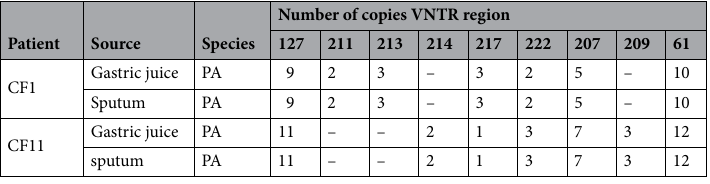
Table 3. VNTR profile for PA isolated form Gastric juice and sputum sample of patient 1 and